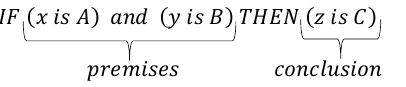
Figure 3. Fuzzy representation of degree of annoyance measure